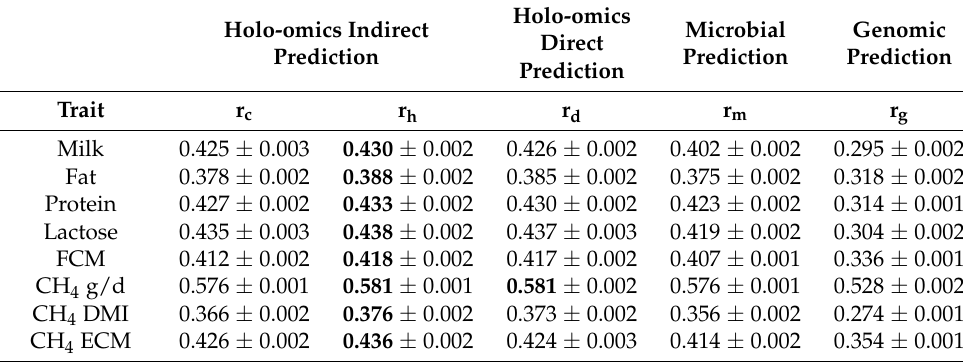
Table 2. Accuracy of holo-omics CORE-GREML (r c ), holo-omics Hadamard (r h ), holo-omics direct (r d ), microbiome (r m ), and genomic prediction (r g ) of milk yield and methane emission traits. The best estimated prediction accuracy values are highlighted in bold text. Holo-omics Microbial Genomic Holo-omics Indirect Direct Prediction Prediction Prediction Prediction